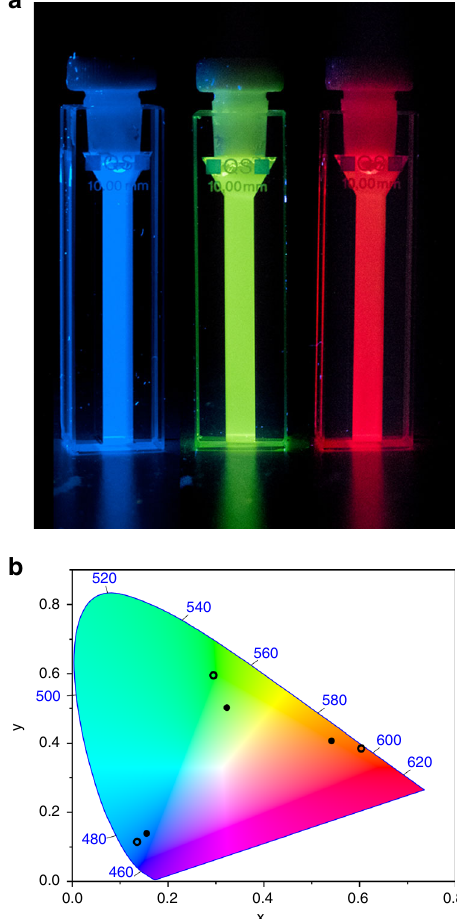
Fig. 4 Emission colors and CIE coordinates. a Photos of the fl uorophores alone in the micelles upon excitation at 365 nm. b Hollow circles: CIE coordinates for the emission from the fl uorophores alone in the micelles: per (0.136, 0.115), DAEg(c) (0.295, 0.596), and DAEr(c) (0.603, 0.385). Solid circles: CIE coordinates for the emission of the tri-component micelle cocktail before UV irradiation (0.156, 0.139), after exposure to 242 nm light (0.323, 0.502) and after exposure to 415 nm light (0.541, 0.407). Please note that all underlying spectra were recorded upon excitation at one and the same wavelength (423 nm). The corresponding coordinates for the sRGB color space are de fi ned as 0.15, 0.06 (blue); 0.30, 0.60 (green); and 0.64, 0.33 (red)